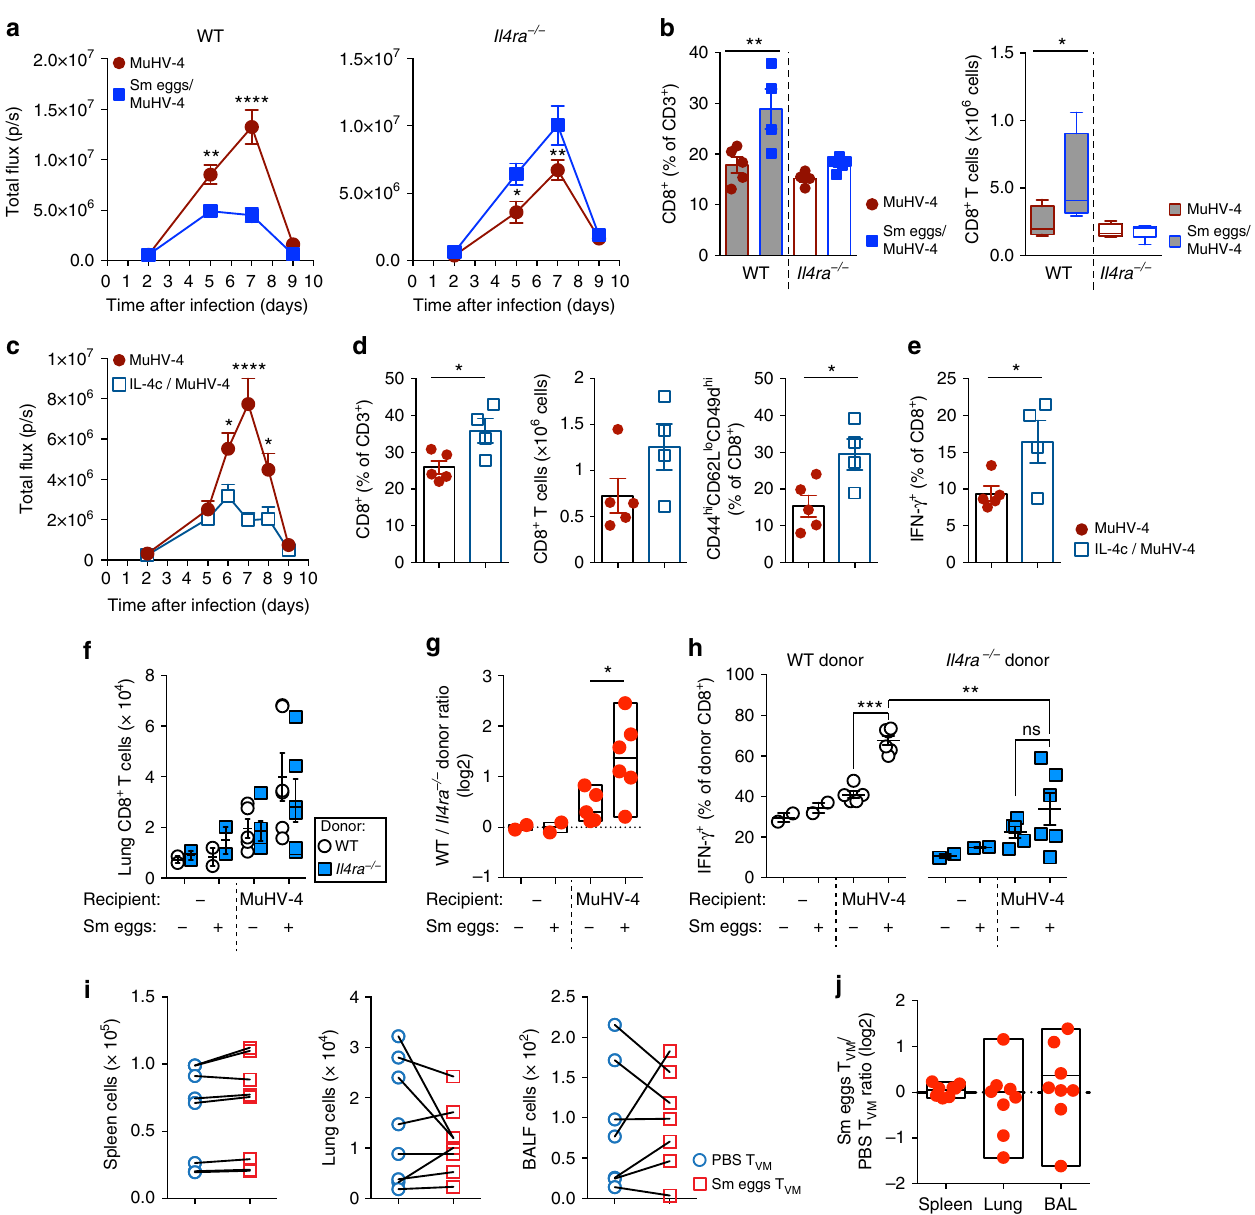
Fig. 7 Helminth-induced IL-4 conditions CD8 + T cells for early control of MuHV-4 infection. BALB/c mice were treated with S. mansoni eggs (Sm) ( a , b ) or treated with IL-4c ( c – e ) before being infected with MuHV-4-luc virus. a Live imaging of combined dorsal and ventral thoracic light emission of WT or Il4ra − / − mice after MuHV-4-luc infection. b Lung CD8 + T cell responses at day 7 pvi in WT or Il4ra − / − mice. c Live imaging of combined dorsal and ventral thoracic light emission of mice subjected to the outlined treatments. d Lung CD8 + T cell responses and proportions of CD44 hi CD62L lo CD49d hi effector CD8 + T cells at day 7 pvi in naive or IL-4c treated mice as in c . e Percentage of IFN- γ producing lung CD8 + T cells by intracellular staining after restimulation with PMA and ionomycin at day 7 pvi. f – h Spleen CD8 + T cells were puri fi ed from WT CD45.1 + or Il4ra − / − CD45.2 + mice treated with PBS or Sm eggs before co-transfer in PBS − or Sm egg-treated congenic CD45.1.2 WT recipient mice, followed by MuHV-4 infection as outlined in Supplementary Figure 7b. f Donor cell numbers in lungs at 7 day pvi. g Ratio of donor cells in lungs at 7 day pvi normalized on uninfected control group (PBS or Sm egg-treated uninfected mice for PBS or Sm egg-treated MuHV-4 infected mice). h Percentage of IFN- γ producing donor CD8 + T cells following restimulation with PMA and ionomycin. i , j CD44 hi CXCR3 hi CD62L hi CD49d lo T VM cells were FACS-sorted from PBS-treated BALB/c CD45.1 + and Sm egg- treated CD45.1.2 + mice, and equal numbers of cells were co-transferred into naive CD45.2 + recipients. One day after adoptive transfer, recipients were infected with MuHV-4. i Total numbers of donor cells in spleen, lung and BALF at day 7 pvi. j Sm egg-T VM vs. PBS-T VM ratios at day 7 pvi. Statistical signi fi cance calculated using two-way analysis of variance (ANOVA) and Sidak ’ s multiple-comparison test ( * P < 0.05, ** P < 0.01, *** P < 0.001, **** P < 0.0001). Data are representative of two to three independent experiments with three to eight mice per group (mean ± s.e.m. in a-f , h ). Each symbol represents an individual mouse; small horizontal lines indicate the